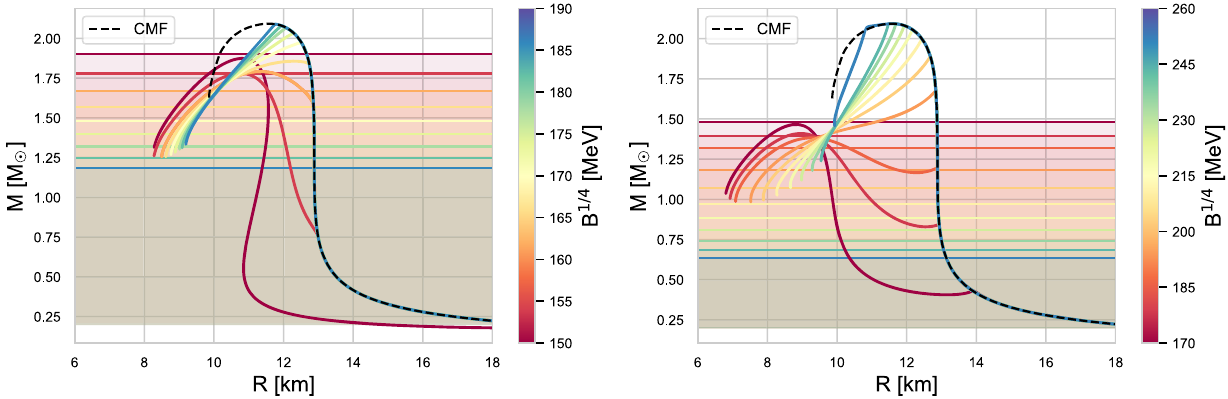
Fig. 4 Mass–radius relations for 2-flavor (left) and 3-flavor (right) Bag-CMF,correspondingtotheEoSsinFig.3(left)and3(right)respec- tively. The color indicates values of the Bag constants, as shown in the colorcodeontherightsideoftheplot.Thehorizontalcoloredlinesindi- cate the maximum masses of pure quark stars using the Bag model with respective bag constant as EoS, see Eq. (8), the shaded regions below